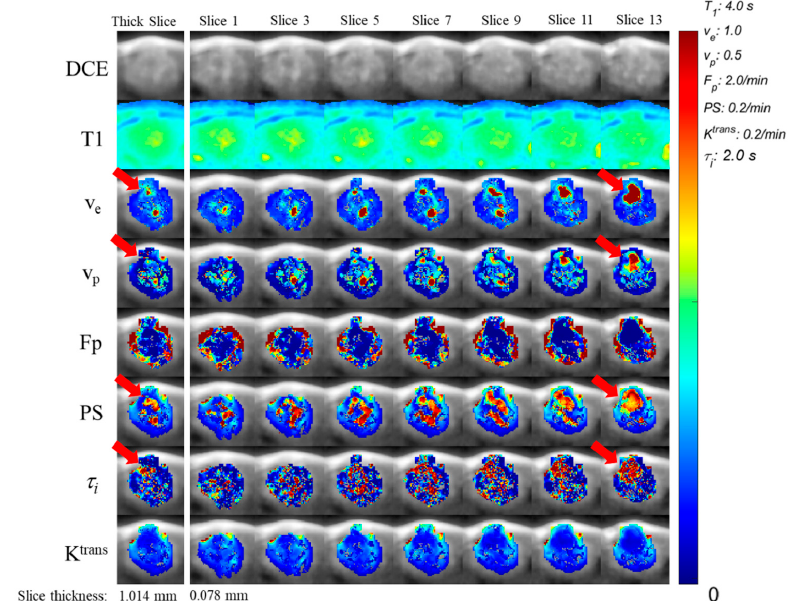
Figure 3. Axial isotropic parameter map slices and the corresponding anisotropic parameter map. The raw Dynamic Contrast-Enhanced MR images of the 13 slices (Slice 1–Slice 13, with a spatial resolution of 0.078 × 0.078 × 0.078 mm 3 ) were vector averaged to simulate the anisotropic data for a thick slice, and then the contrast kinetic analysis was conducted to obtain the parameter maps shown on the left (spatial resolution of 0.078 × 0.078 × 1.016 mm 3 ). Red arrows indicate large